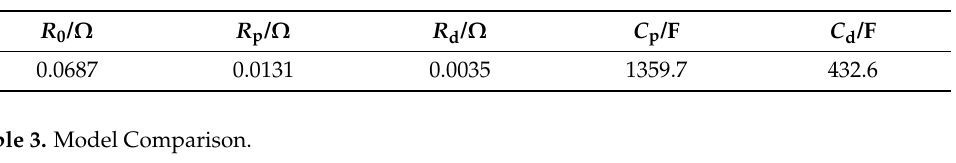
Figure 10. Fitness Curve. Table 2. Model Parameters.